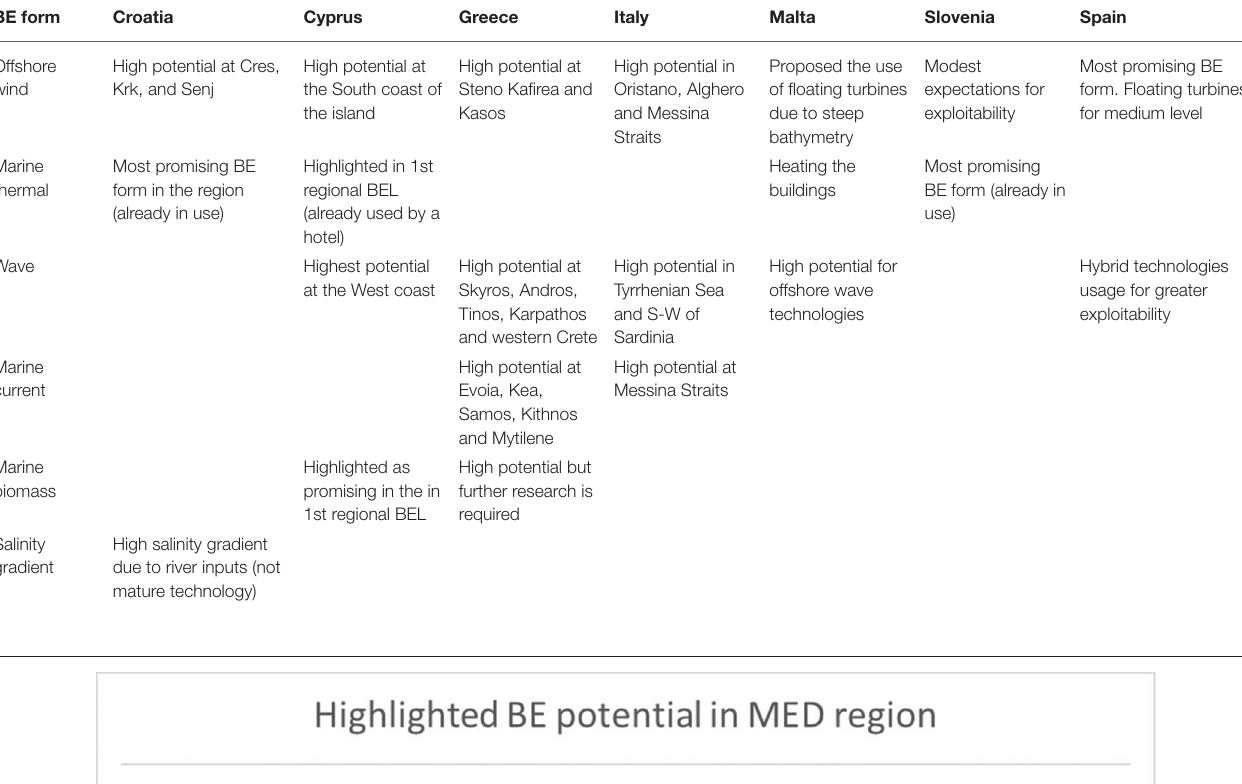
TABLE 3 | Highlighted BE forms in the seven participating countries in the MED region. BE form